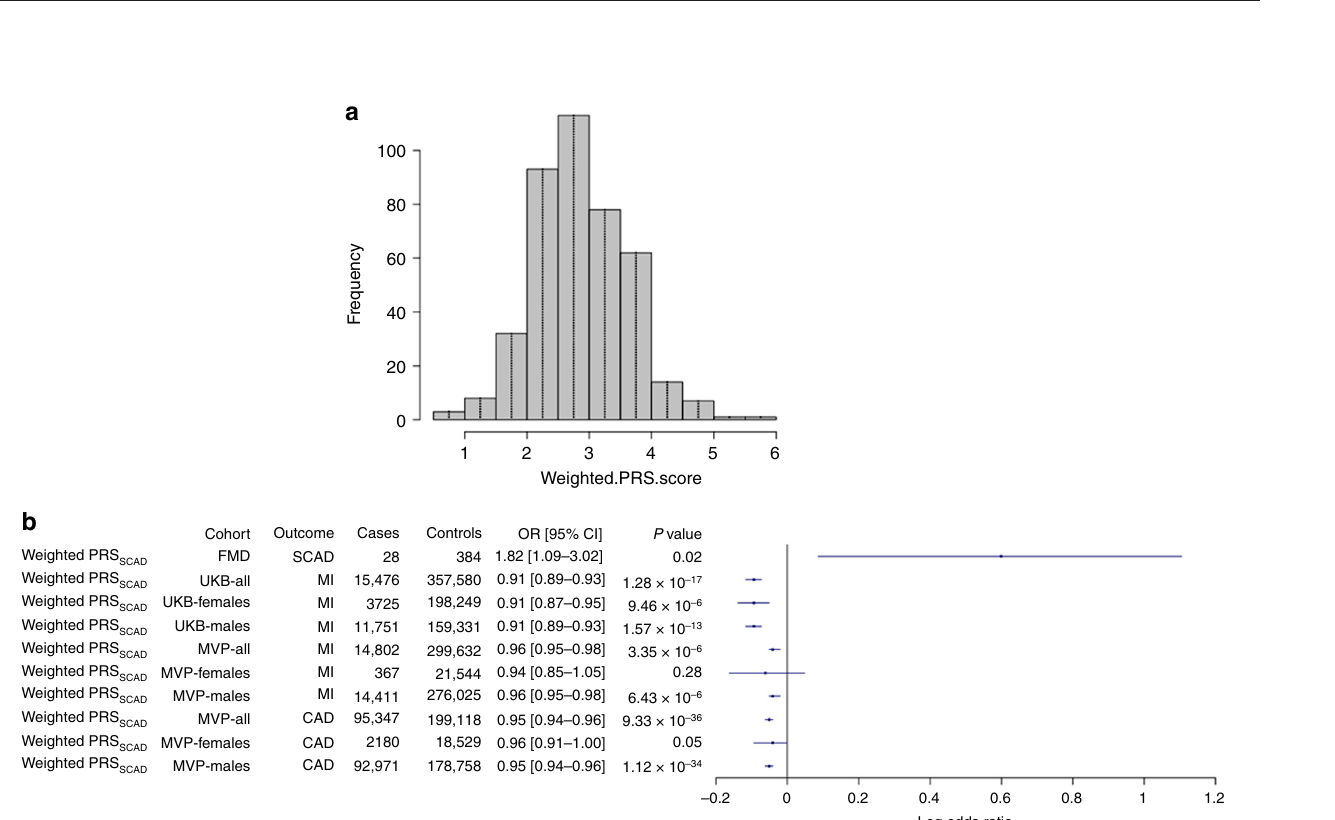
Fig. 4 PRS SCAD and prevalent SCAD and MI events in an FMD cohort and the UK Biobank. a Histogram of the weighted PRS SCAD based on FMD cohort ( N = 412) with overlaying the corresponding data points in each interval. b The ORs and corresponding 95% CIs are shown for the association of PRS SCAD with SCAD-MI, all MI, or CAD/MI, in the FMD cohort ( n = 412, which includes 28 SCAD cases), UK Biobank ( n = 373,056, which includes 15,476 CAD/MI cases), and MVP ( n = 294,465, which includes 95,347 CAD cases; n = 314,434, which includes 14,802 MI cases). The logistic regression Wald statistic of two-sided P values are displayed. All models are adjusted by age, sex, and PCs. P values are unadjusted for multiple